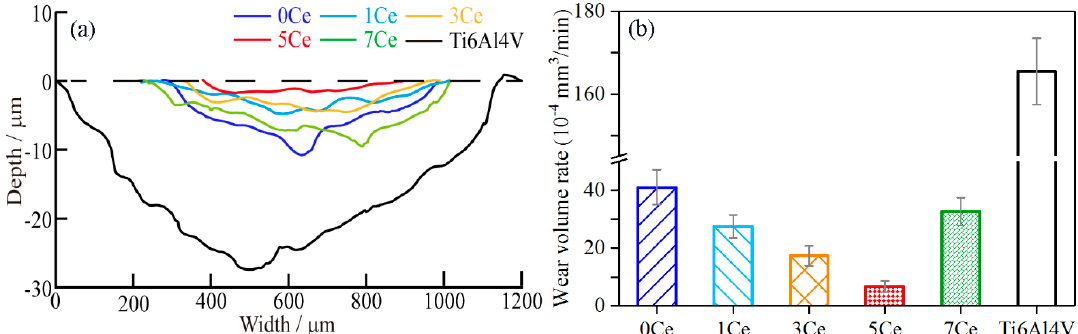
Figure 7. ( a ) The section profiles of a typical wear track; and ( b ) the wear volume rates of the substrate and the coatings.